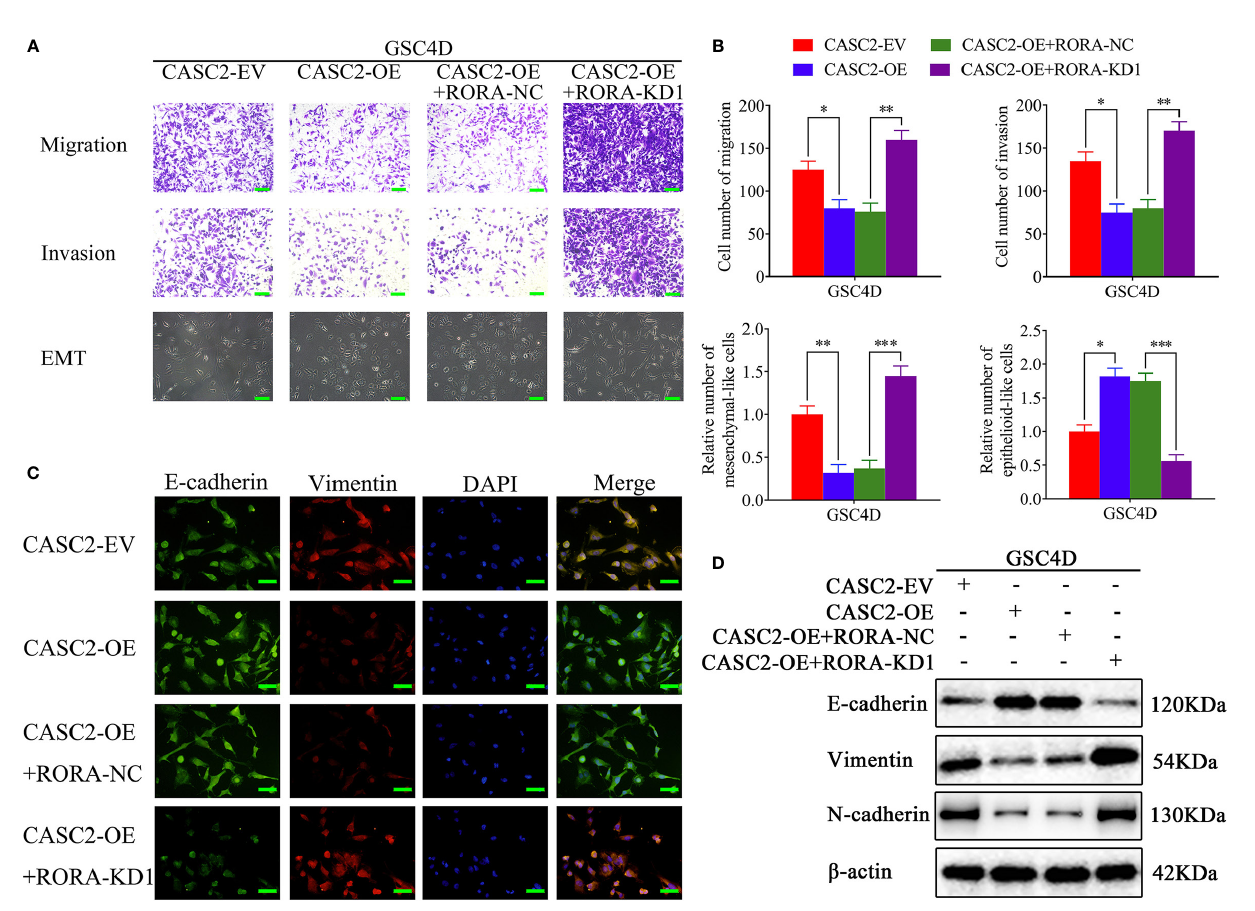
FIGURE 5 | CASC2 inhibits the migration, invasion, and EMT of GBM, and the inhibitory effects are reversed by RORA knockdown. (A, B) Representative migration assays and Transwell assays showing the migration rates and invasion rates, and representative microphotographs showing the morphological changes in CASC2- overexpressed GSC4D, reversed by RORA knockdown, and the negative control. The migration assay and Transwell assay: scale bar = 100 m m, microphotographs: scale bar = 50 m m. (C , D) Representative immuno fl uorescence staining (C) and western blotting (D) showing the changes in E-cadherin, vimentin, and N-cadherin in GSC4D with CASC2 overexpression, reversed by RORA knockdown. Scale bar = 50 m m. EV, empty vector; OE, overexpression; NC, negative control; KD, knockdown. All data are expressed as the mean ± SD (three independent experiments). *P < 0.05; **P < 0.01; ***P <